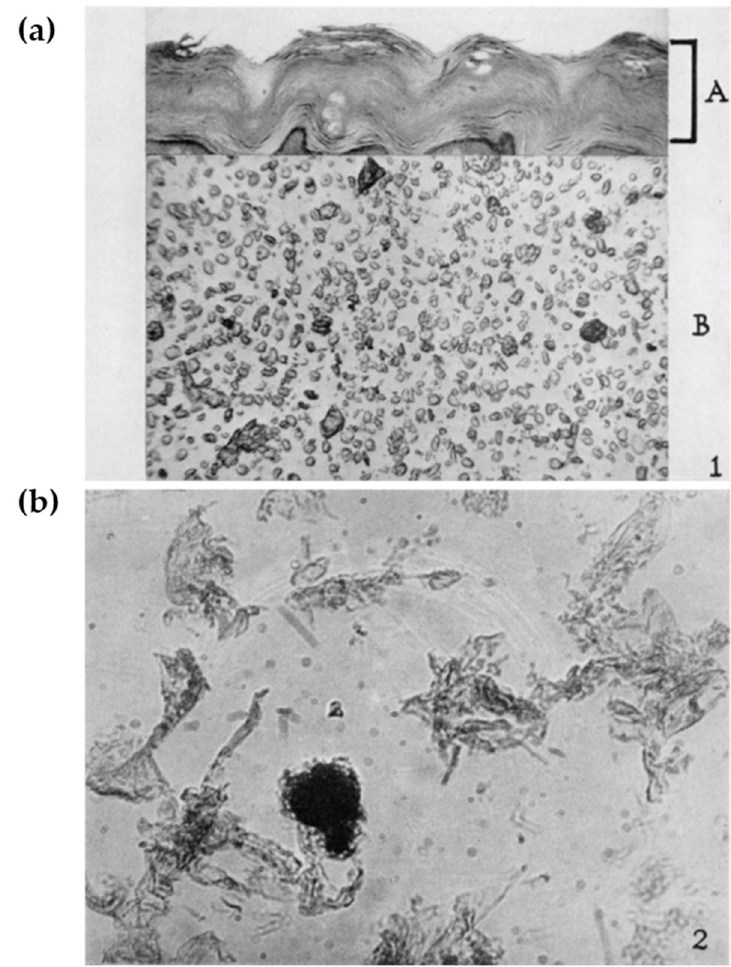
Figure 1. ( a ) A cross-section of human plantar skin showing thickly cornified epithelium (A section). Pulverized callus showing single corneocytes. ( b ) Isolated cell-membrane-like remnants of corneocytes after exhaustive hydrolysis. Adapted from Ref. [13] (Copyright, 1955, by The Rockefeller Institute for Medical Research).